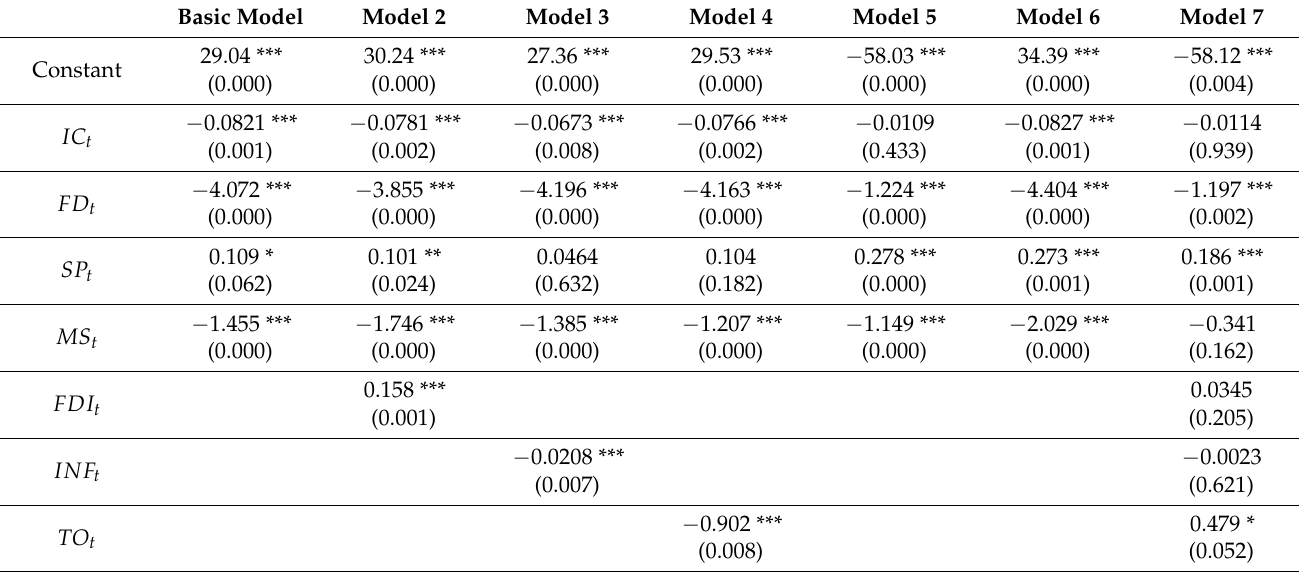
Table 2. Fixed-effect-panel-data estimations for 23 OECD countries, yearly data